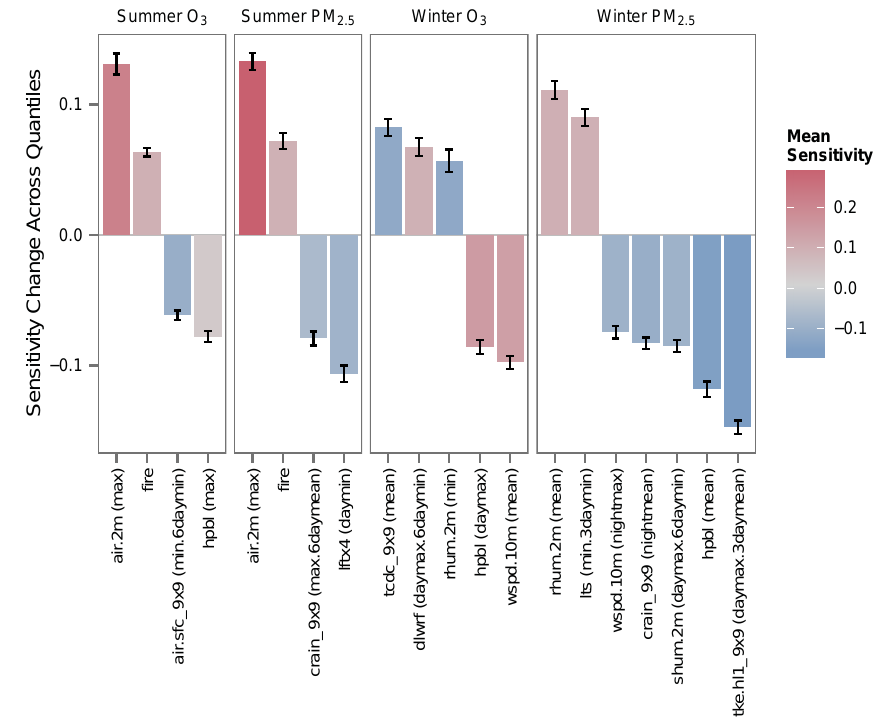
Figure 10. Normalized pollutant concentration sensitivities to meteorological covariates (0.0 = uniform sensitivity across quantiles). Values shown here are the weighted least-squares regressions performed on normalized QR coefficients as a function of quantile for covariates with a mean sensitivity change of at least 0.05, by species and season. Colors of bars show mean normalized sensitivities (roughly equivalent to slopes expected from an ordinary least-squares regression), while magnitudes of bars show mean change across quantiles, averaged over all stations. Error bars indicate standard error of the mean. 0.5 ppb O 3 ◦ C − 1 at the 5th percentile, but a much larger in- crease of 1.5 ppb O 3 ◦ C − 1 at the 95th percentile. This